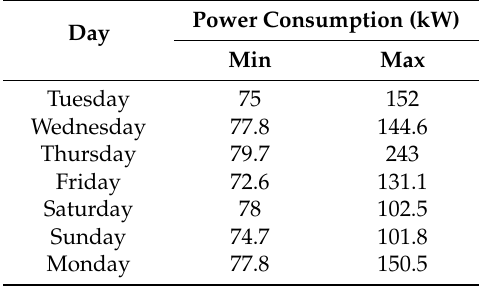
Table 5. Simulation scenarios.